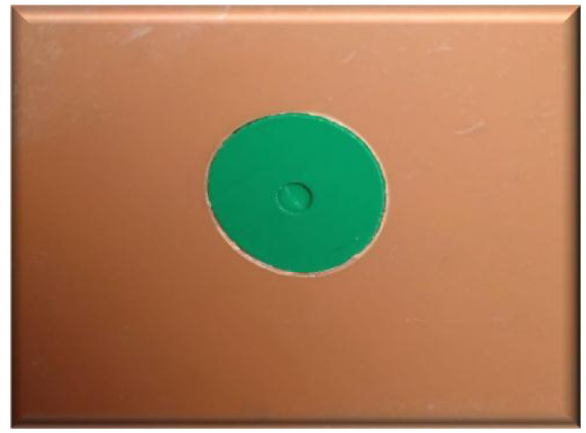
Fig. 11. Synthetic discontinuities facing the inside of the PVC piping.